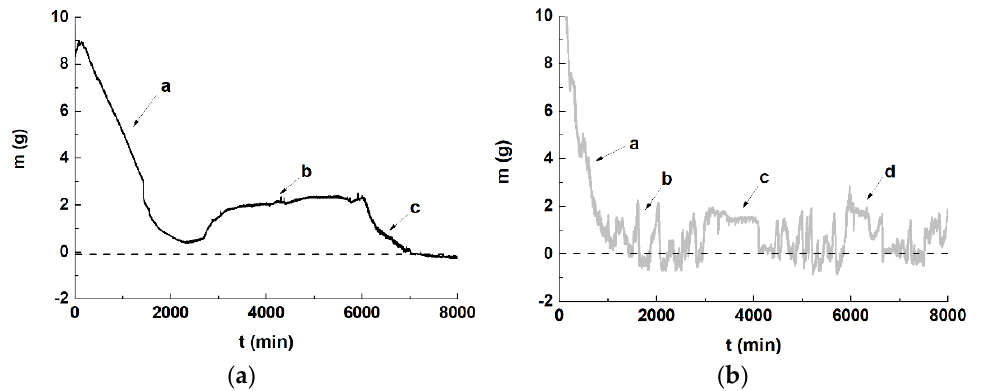
Figure 11. The mass change curves of the water-containing coarse plaster and salt-containing coarse plaster tested by double-layer surface contact internal pressure method ( a ) water-containing coarse plaster; ( b ) salt-containing coarse